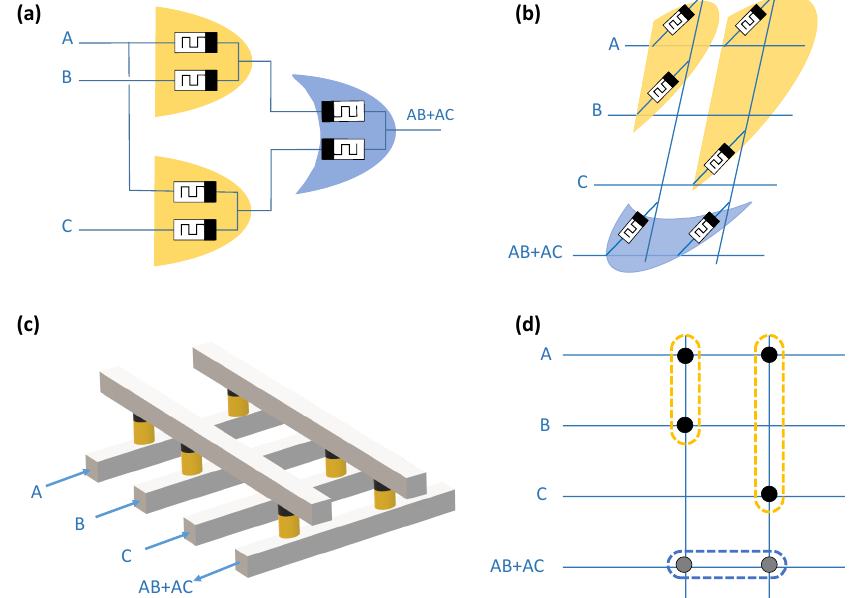
Figure 7. Example of an MRL logic function performed using X-MRL. Reproduced with permission from [12], Copyright 2019,